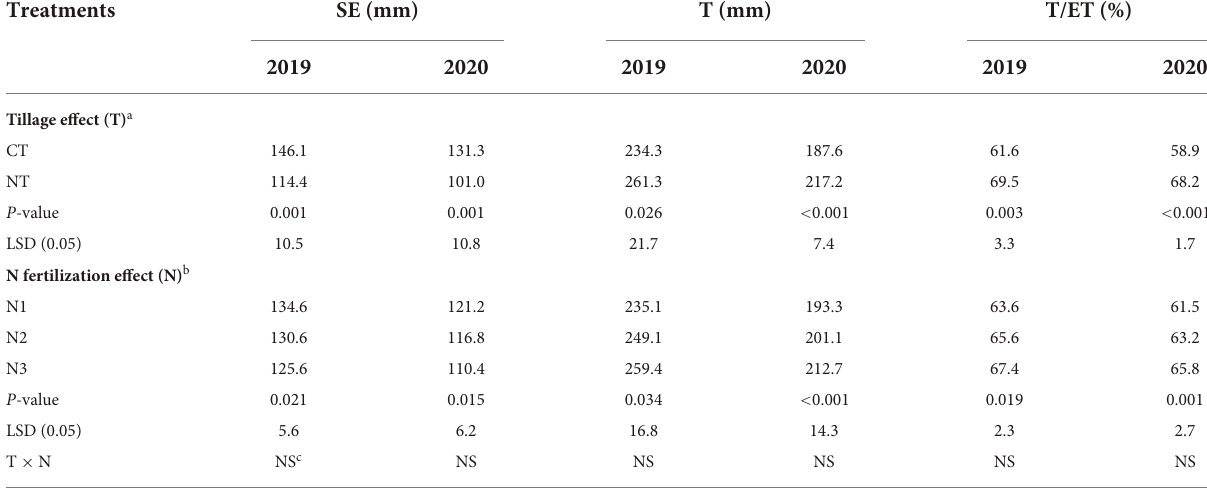
TABLE 2 The soil evaporation (SE), transpiration (T), and ratio of transpiration to evapotranspiration (T/ET) of spring wheat during growth period as affected by tillage and N fertilization treatments in 2019 and 2020. Treatments SE (mm) T (mm) T/ET (%)